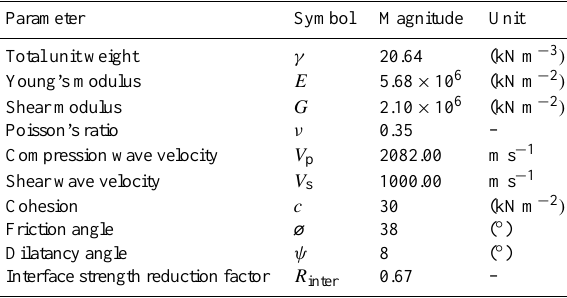
Table 8. Material parameters of Mohr-Coulomb model for firm soil considered in FE analysis.